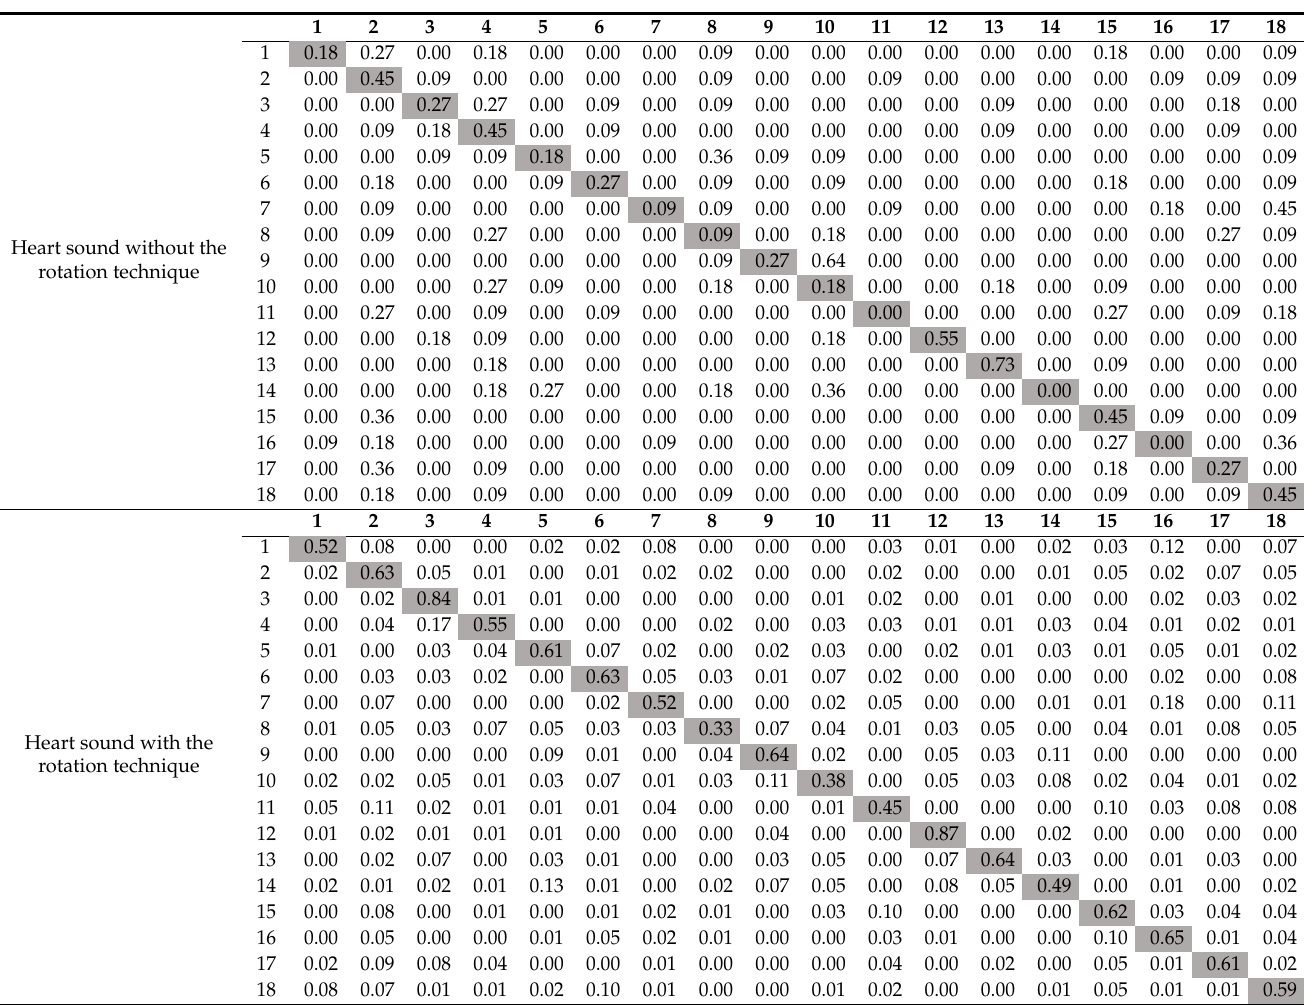
Table 4. The confusion matrices for the heart sound biometric with and without the image augmentation technique showing true classes (rows) versus predicted classes (columns) for 18 subjects (also known as classes). 1 indicates 100% of the samples in the corresponding class were predicted correctly, while 0 indicates no correct predictions. Classes are marked in green if the prediction accuracy is 90% or more.